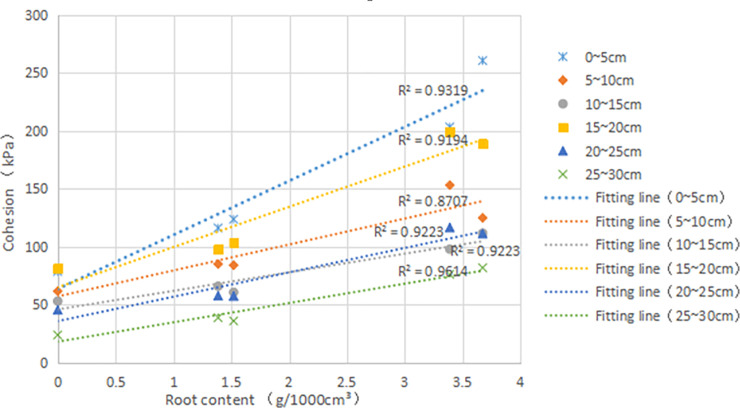
Cohesion (c, kPa) versus root content (δ, g•1000cm-3) in different depth(cm): R2, goodness of fit.